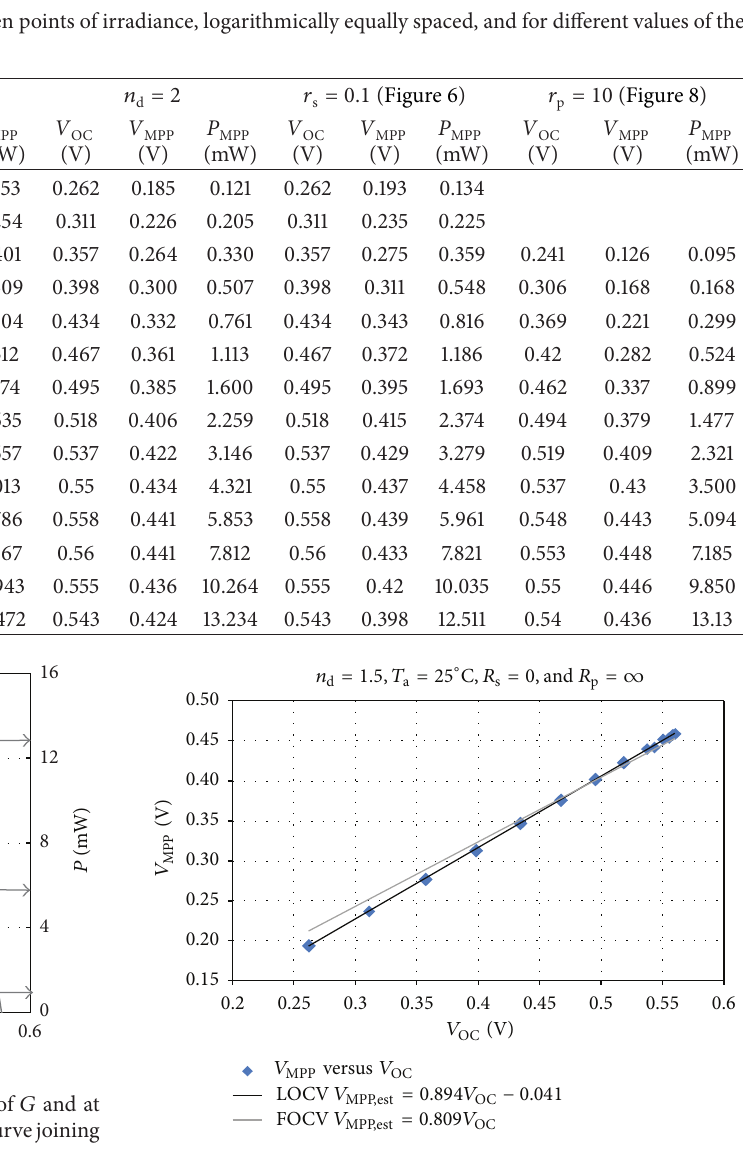
Figure 3: Computed 𝑉 versus 𝑉 for a single PV cell. Two MPP OC least-square regression lines are also represented: the grey line corresponds to the FOCV method with 𝑘 = 0.809 whereas the black line corresponds to the LOCV method with 𝑎 = 0.894 and = 25 ∘ C, 𝑏 = −0.041 . The parameters of the PV cell model are 𝑇 a = 1.5 , 𝑅 = 0 , and 𝑅 = ∞ 𝑛 d s p